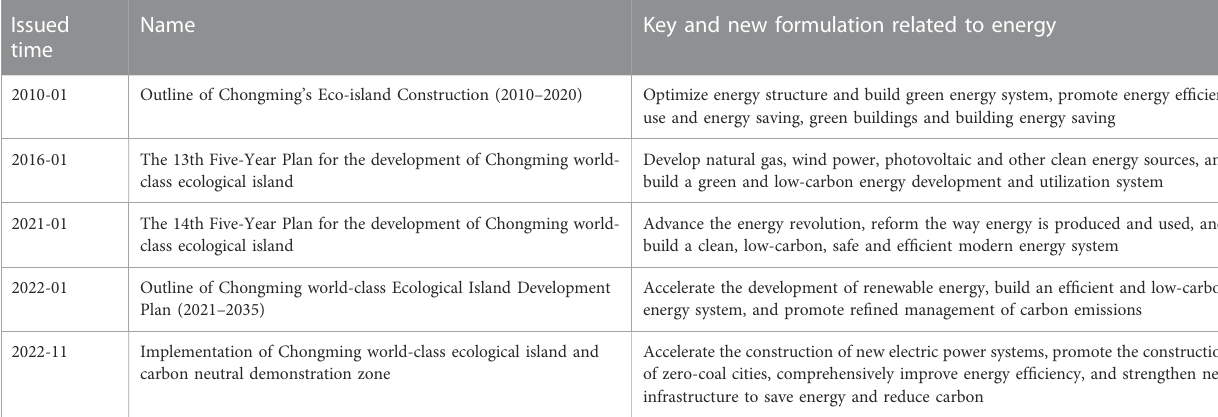
TABLE 1 Key policies and guidelines on the transition of Chongming to the world-class ecological island. Issued Name Key and new formulation related to time